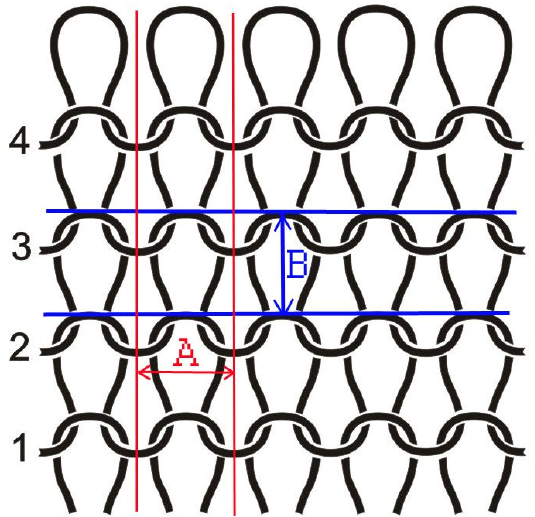
Figure 1. Structure model of knitted fabric indicating segments A and B.